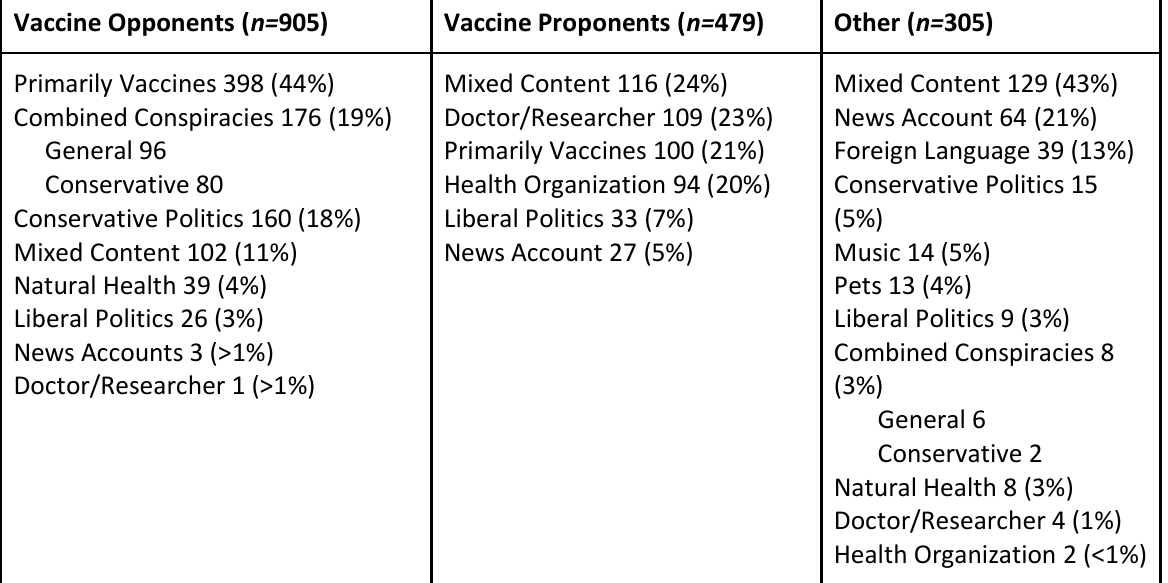
Table 1. Breakdown of top vaccine accounts on